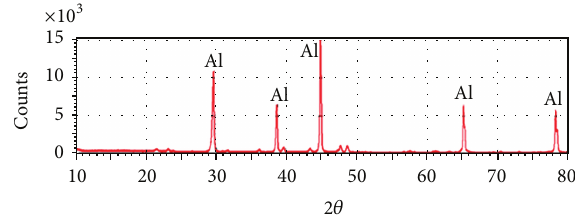
Figure 14: X-ray diffraction pattern of the Al-Al GMAW joint. Mainly peaks of pure 𝛼 Al are eminent.